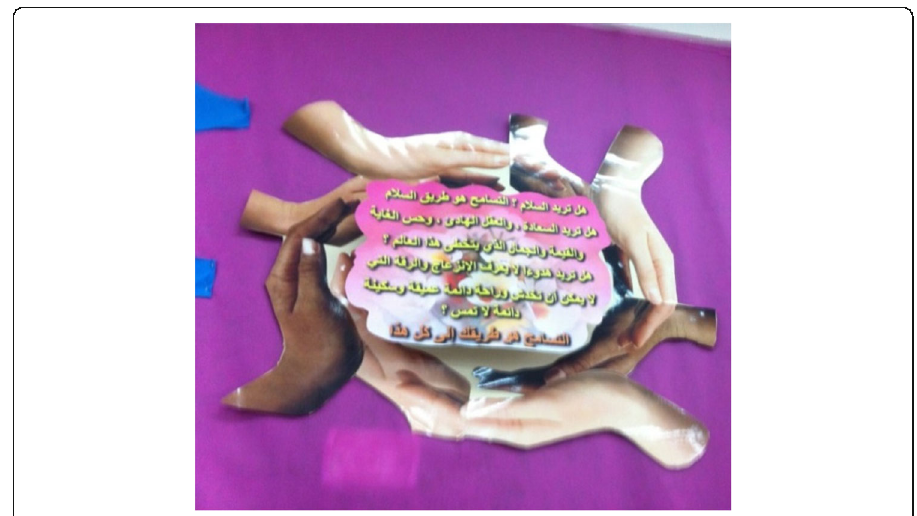
Fig. 12 An example of a symbolic sign on teaching